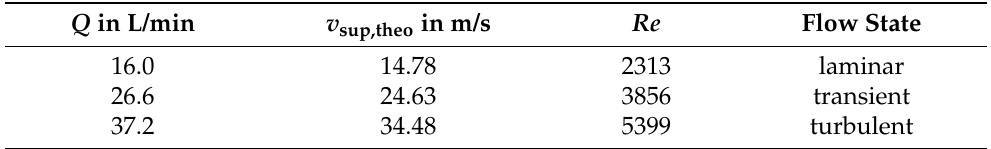
Table 2. Experimental parameter for the volume flow Q , theoretical flow velocity v sup,theo , Reynolds number Re and expected flow state for measurements on the fluid-tool interaction with nozzle width of w = 20 mm and height of h = 0.9